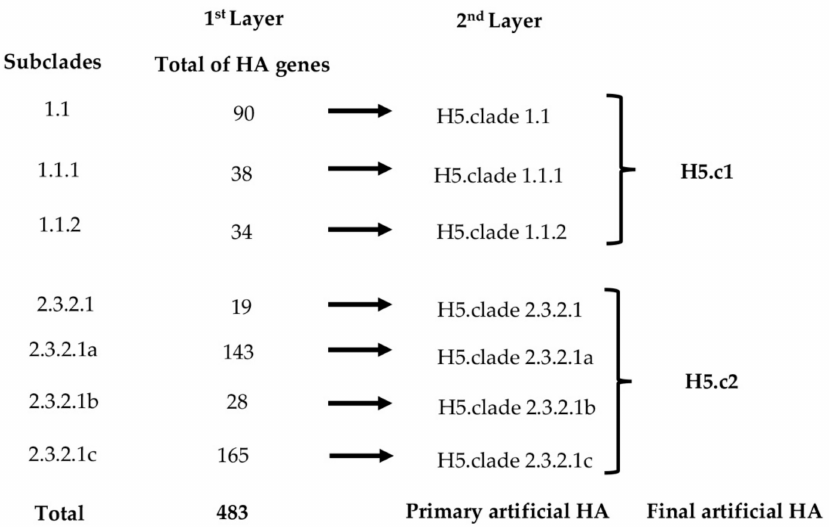
Figure 1. Schematic of designing artificial haemagglutinin (HA) sequences of artificial haemagglutinin (A / H5N1) from poultry in